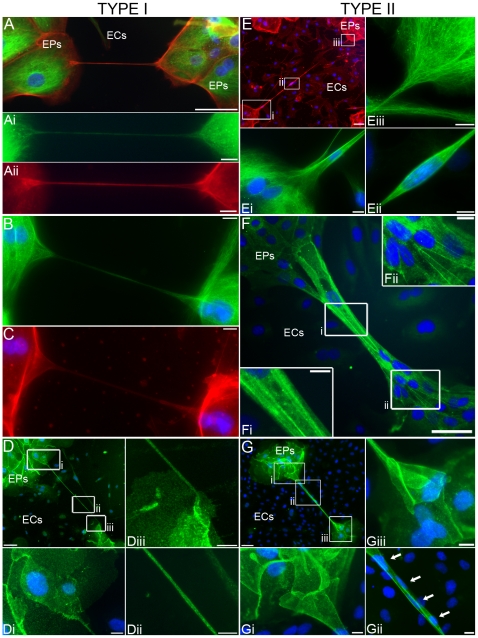
Characterization of types I and II EP bridge structures.
A–C: Type I EP bridges connect a single cell from one EP island and a single cell from another EP island. (A) Color composite and color separation (Ai-Aii) of F-actin (red), microtubule (green), and nucleus (blue) staining showed an EP bridge connecting a single cell from one EP island to a single cell from another EP island. (B–C) Another type I EP bridge distinctly shows a connection between two cells from different EP islands. D: Nucleus (blue) and E-cadherin (green) immunostaining of a type I EP bridge extending 376 µm over ECs connecting 2 EPs. E: F-actin (red), nucleus (blue), and microtubule (green) immunostaining displayed F-actin (E) and microtubule architecture (Ei-Eiii) of a 570 µm type II EP bridge containing a nucleus at the lower end (Ei) and in the middle (Eii) of the conduit. F: Nucleus (blue) and E-cadherin (green) immunostaining showed a type II EP bridge as a continuous multi-cellular structure between EP islands. G: A type II EP bridge immunostained for E-cadherin (green) and nuclei (blue) structured with complex connections (Gi, Giii) between EP islands contained 4 nuclei (Gii, arrows indicate nuclei). Terminus of the EP bridge (Giii) resembled an elastic sheath similar to the structure observed in Fig. 4A: 7–10 h. Scale bars: (A, D–G), 50 µm; (Ai-Aii, B, C, Di-Diii, Ei-Eiii, Fi-Fii, Gi-Giii), 10 µm.